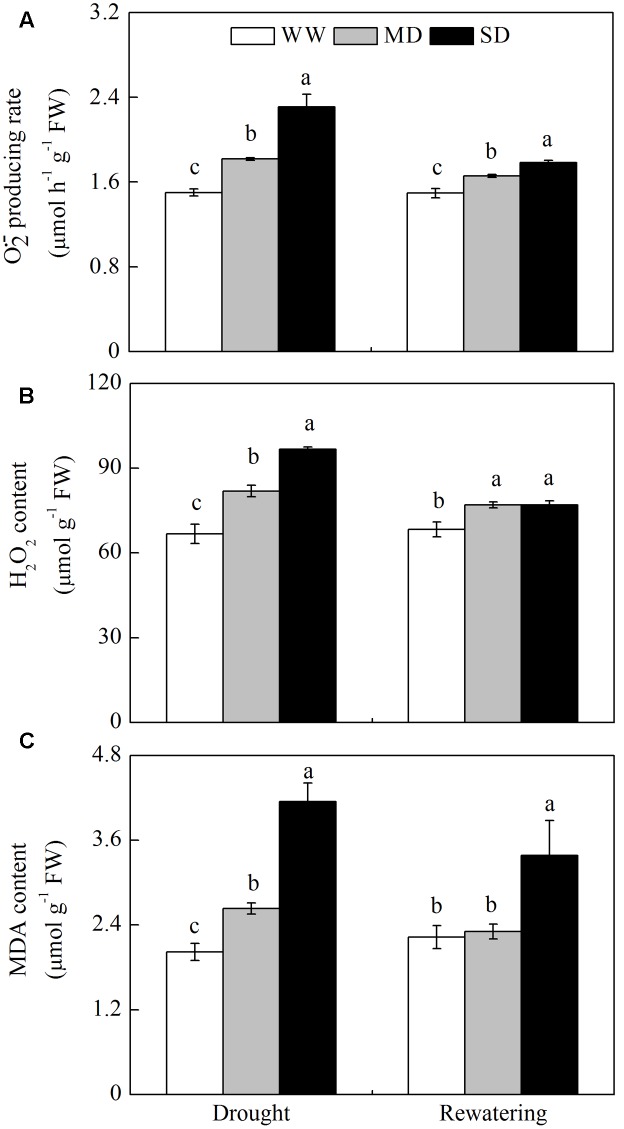
Changes in reactive oxygen species (ROS) and lipid peroxidation of F. rufa plants under drought and rewatering. (A) superoxide anion (O2•−) producing rate, (B) hydrogen peroxide (H2O2), and (C) lipid peroxidation (MDA content). Well-watered (WW, open bars), moderate drought (MD, gray bars), and severe drought (SD, closed bars). Data are the means of four replicates with SE shown by vertical bars. Different letters within the same stage indicate significant differences (P < 0.05) according to Duncan’s test.